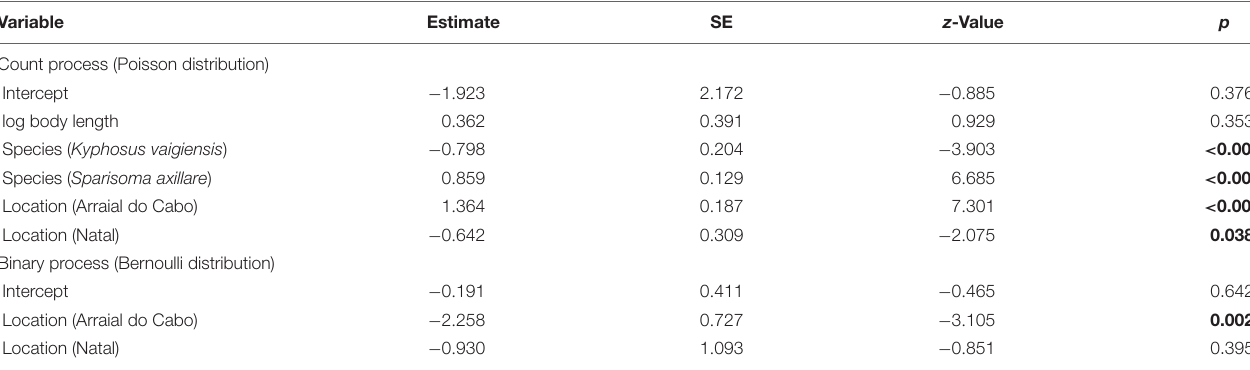
TABLE 4 | Parameters estimates for the final zero-inflated Poisson generalized linear model for the association between different herbivorous reef fishes, location, and number of debris ingested as the response variable. Variable Estimate SE z -Value p